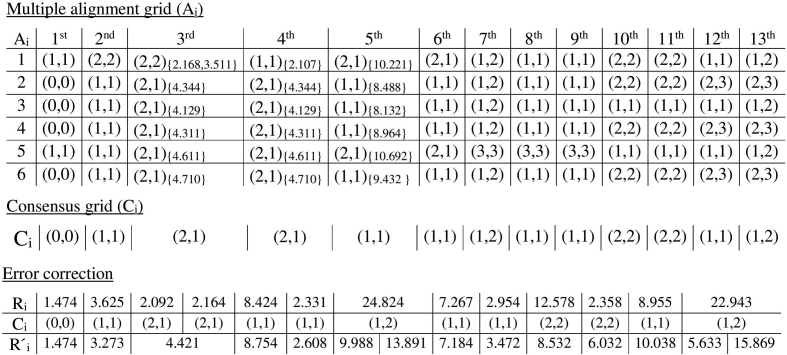
Example of a multiple alignment grid and a consensus grid. The figure shows the multiple alignment grid \documentclass[12pt]{minimal}
\usepackage{amsmath}
\usepackage{wasysym}
\usepackage{amsfonts}
\usepackage{amssymb}
\usepackage{amsbsy}
\usepackage{upgreek}
\usepackage{mathrsfs}
\setlength{\oddsidemargin}{-69pt}
\begin{document}
}{}$\mathsf {A}_i$\end{document} for an Rmap Ri and its consensus grid \documentclass[12pt]{minimal}
\usepackage{amsmath}
\usepackage{wasysym}
\usepackage{amsfonts}
\usepackage{amssymb}
\usepackage{amsbsy}
\usepackage{upgreek}
\usepackage{mathrsfs}
\setlength{\oddsidemargin}{-69pt}
\begin{document}
}{}${\rm C}_i$\end{document}. Each row of the multiple alignment grid represents the alignment of Ri with one of its related Rmaps, and the columns represent the fragments of Ri. The figure also demonstrates error correction using the consensus grid, with the error-corrected Rmap denoted as \documentclass[12pt]{minimal}
\usepackage{amsmath}
\usepackage{wasysym}
\usepackage{amsfonts}
\usepackage{amssymb}
\usepackage{amsbsy}
\usepackage{upgreek}
\usepackage{mathrsfs}
\setlength{\oddsidemargin}{-69pt}
\begin{document}
}{}$R^{\prime }_i$\end{document}. The fragment sizes are in Kbp. To demonstrate the error correction process for the 3rd, 4th, and 5th fragments, we also include the fragments (in parentheses) to which they align. The error-corrected fragment is the mean of the fragments from the corresponding positions that have the same alignment as the consensus. For example, for the 5th fragment, the consensus is (1,1). Therefore, the mean of the aligned fragments with (1,1) alignment, i.e., 8.488, 8.132, 8.964, and 9.432, is the error-corrected value for the 5th fragment.